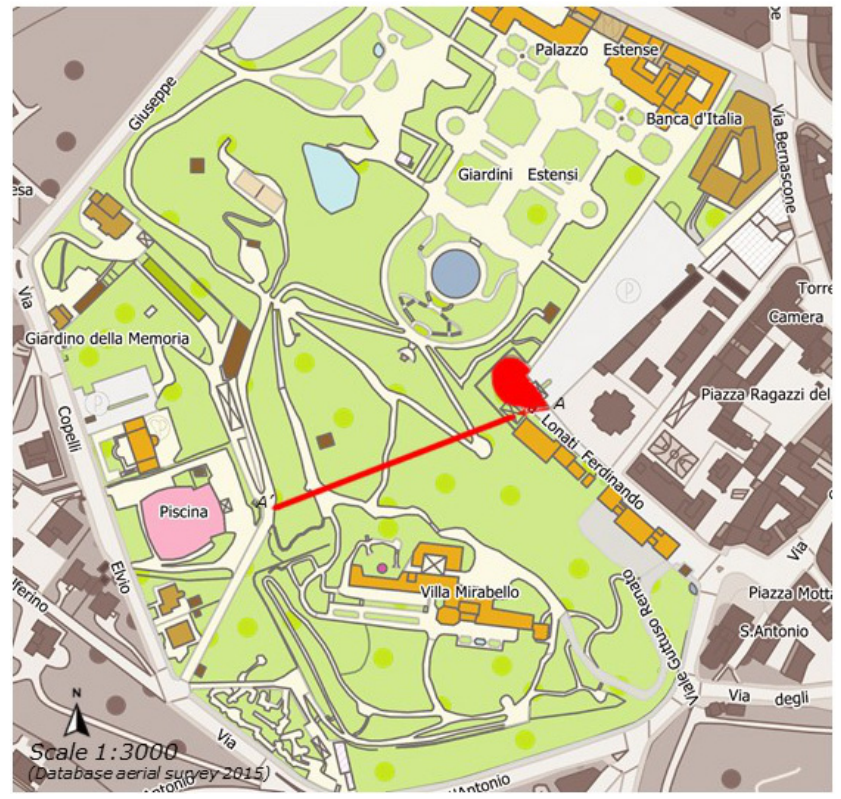
Figure 4. Map of the area of the Estensi Gardens (red line: the air-raid shelter; and red area: parking area). Elaboration by A.